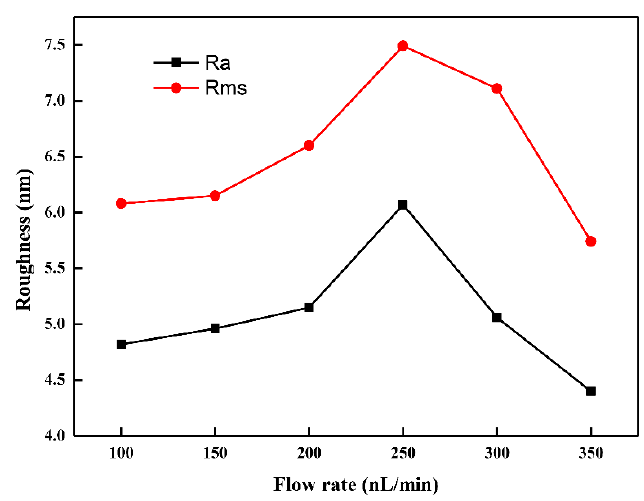
Figure 11. The roughness of the deposited micro pattern. (Rms is the root mean square average of the height deviations taken from the mean data plane; Ra is the arithmetic average of the absolute values of the surface height deviations measured from the deposited micro pattern).